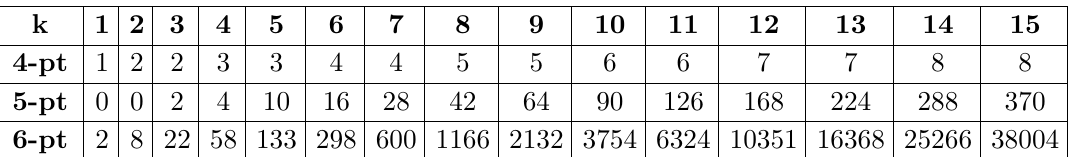
Table 2 . Counting of scalar kinematic numerator seeds up to 6-point and at O (1 / Λ 2 k ) for k ≤ 15 in the EFT expansion. The Gram determinant constraints relevant in 4 spacetime dimensions have been accounted